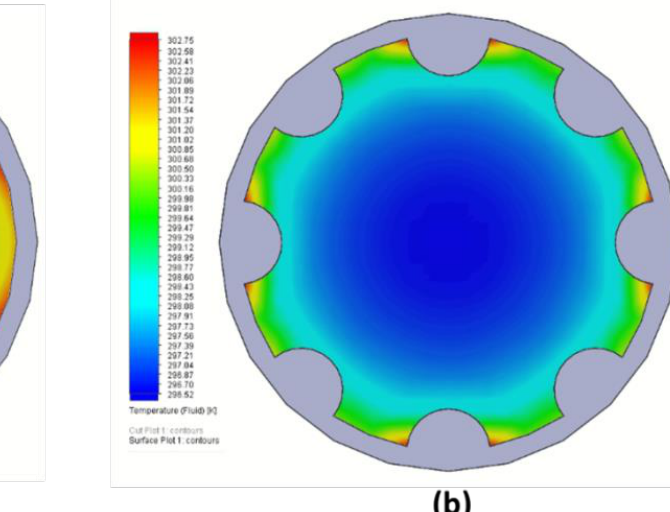
Figure 21. The fluid temperature in the outlet cross-section for the ( a ) reference empty tube [296.67 – 299.35 K], ( b ) tube with circular fins [296.52 – 302.75 K], ( c ) tube with rectangular fines [296.57 – 300.18 K], and ( d ) tube with triangular fins [296.67 – 299.58 K].